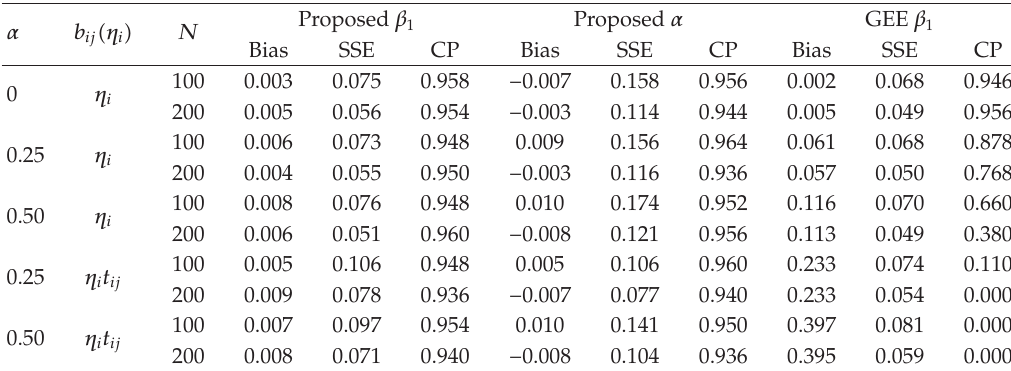
Table 2: Simulation results for mixed types of